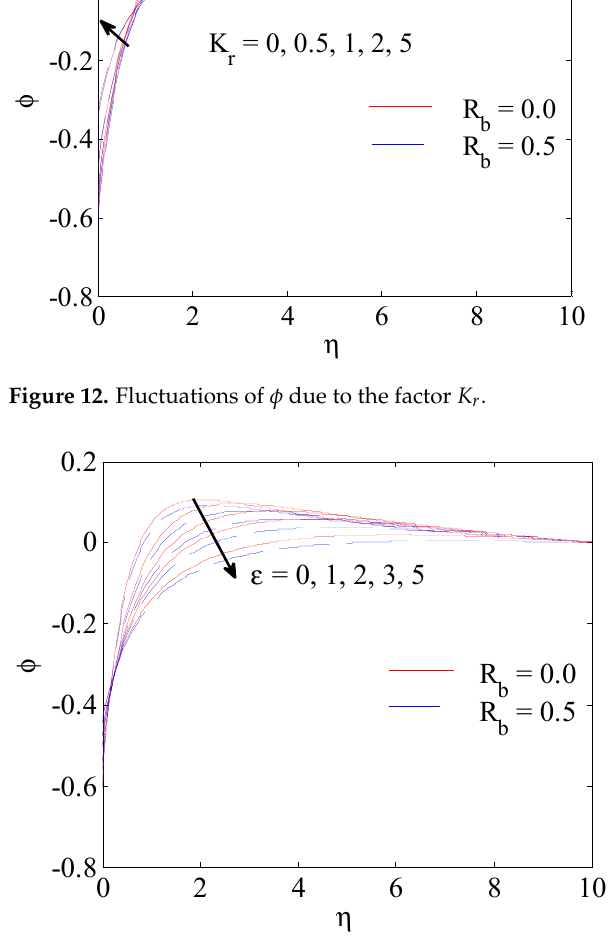
Figure 13. Fluctuations of ϕ due to the factor ε .